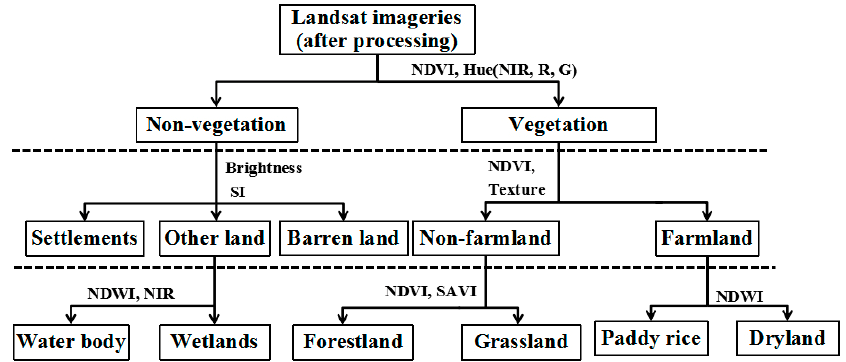
Figure 2. Decision-tree models for grassland classification of the west Jilin Province in 2017. (The threshold of each rule set varied with images. NIR is near-infrared band, R is red band, G is green band. NDWI is the Normalized Difference Water Index, calculated from G and NIR bands).